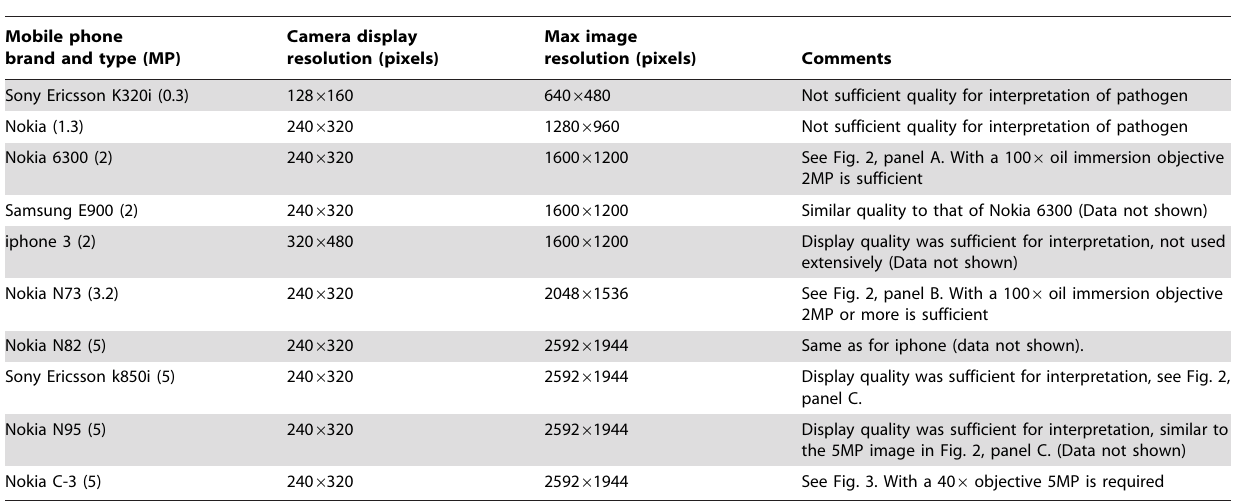
Table 1. Types of mobile phones and resolutions tested are shown.